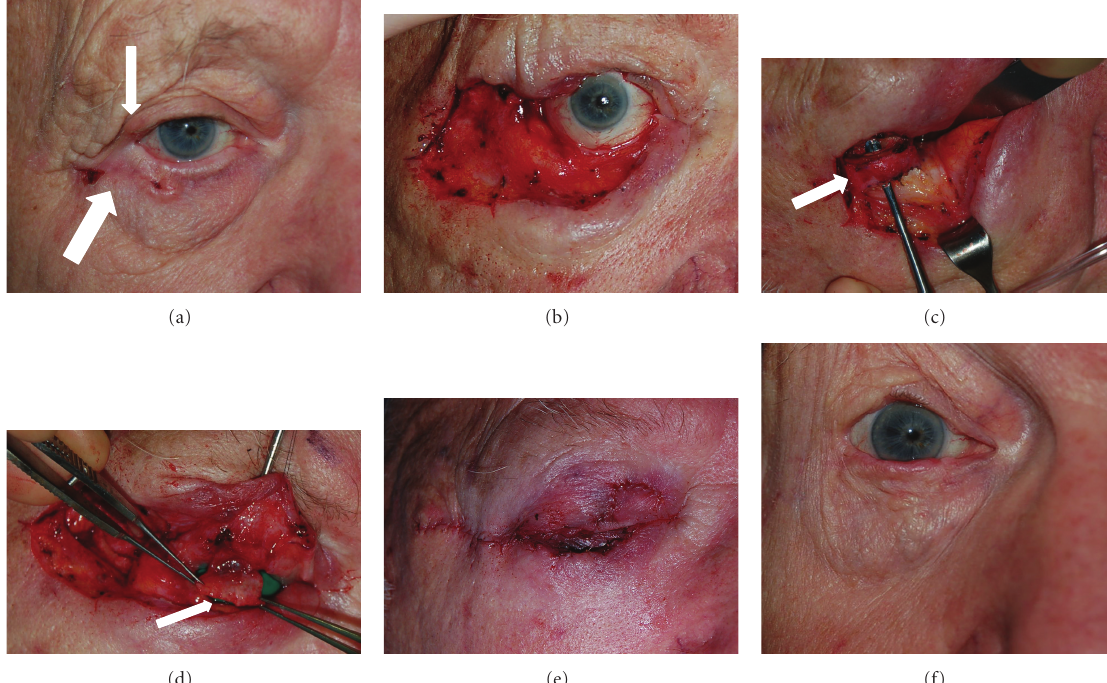
Figure 1: (a) Initial presentation of basal cell carcinoma in an 89-year-old patient involving the right lower eyelid (thick arrow) and right upper eyelid (thin arrow). (b) After Moh’s resection, a large surgical wound measuring 5cm by 2cm involving 95% of the right lower eyelid and 60% of the right upper eyelid is present. (c) A periosteal flap was elevated from the lateral orbital rim and rotated medially to reconstruct the posterior lamella of the upper lid and provide an anchor for the lower lid. (d) A tarsoconjunctival flap was then harvested from the remaining superolateral tarsus of the right upper lid and rotated inferiorly to reconstruct the posterior lamella of the right lower eyelid (arrow). (e) Completed reconstruction with anterior lamellar full thickness skin graft from the left upper eyelid. (f) One year